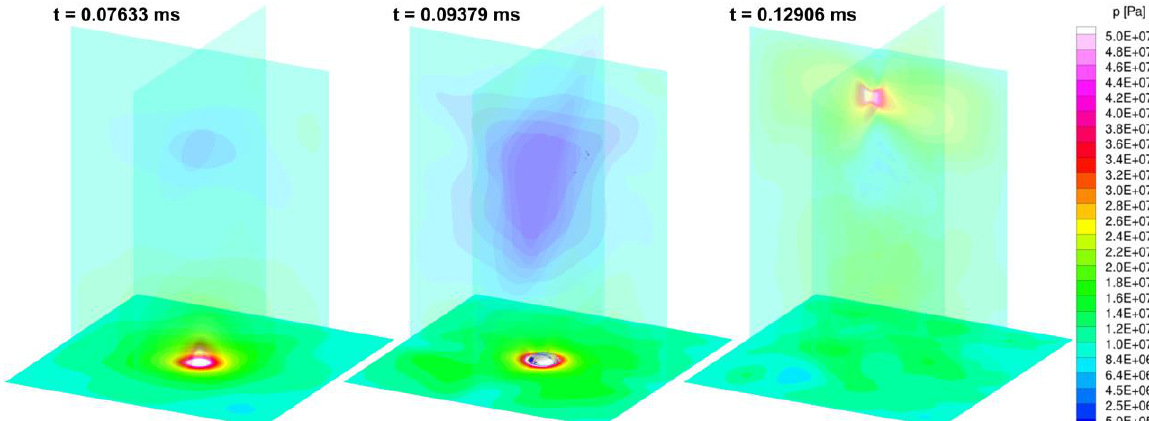
Fig. 7. Setup I: Pressure field depicted on two intersecting slices of the inner domain. White structures are iso-surfaces of vapor ratio equal to 5%. The initial vapor parameter and therefore interaction parameter increase from left to right .